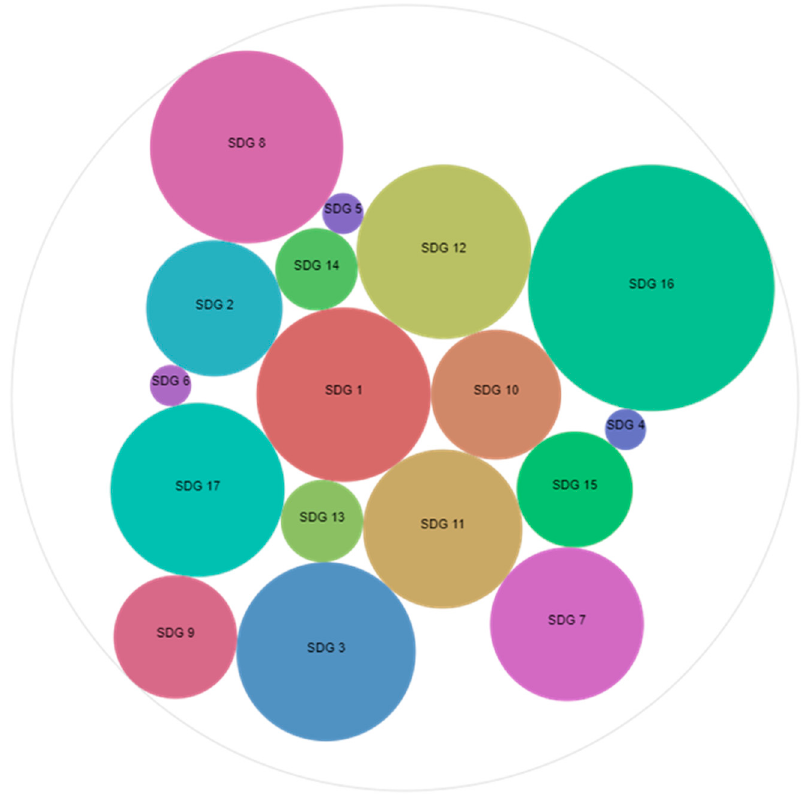
Figure 2. Blockchain projects addressing each SDG. Source: Created by the authors based on data from [6].